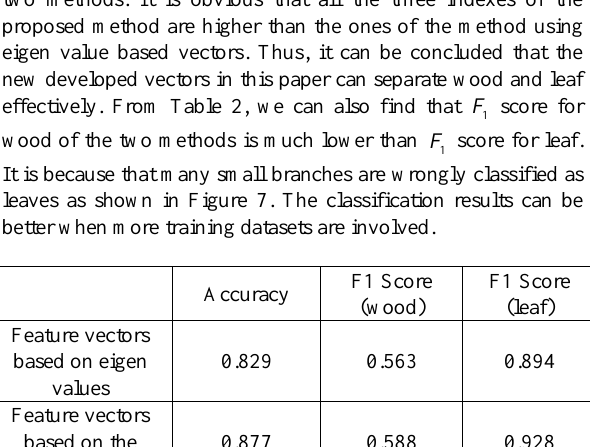
Figure 7. wood-leaf classification results using different vectors. (a) Classification result using the vectors based on eigen values; (b) Classification result using the proposed method.